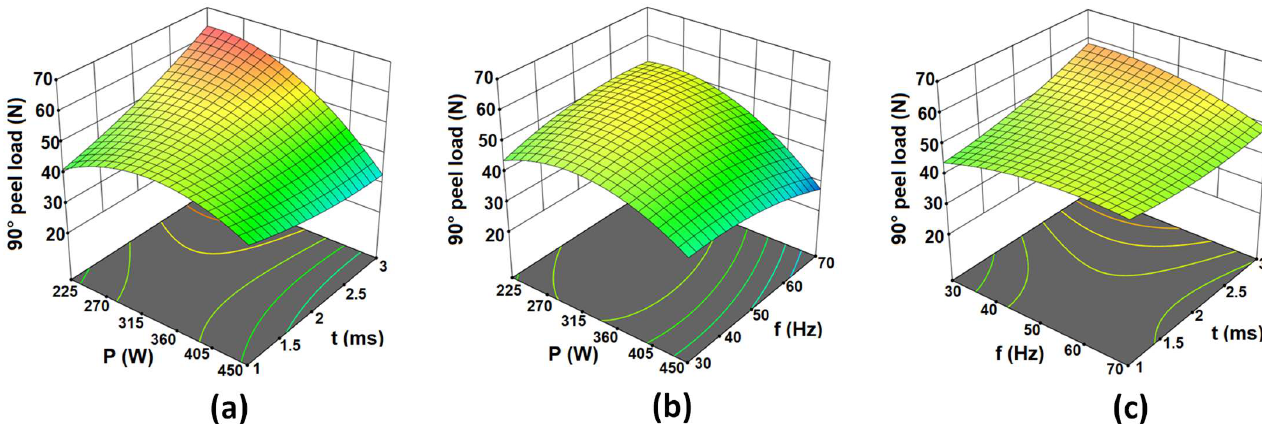
Figure 4. Response surface plots showing the interaction effects of ( a ) P and t, ( b ) P and f and ( c ) f and t on the PL, while the third parameter is at their respective centre value.